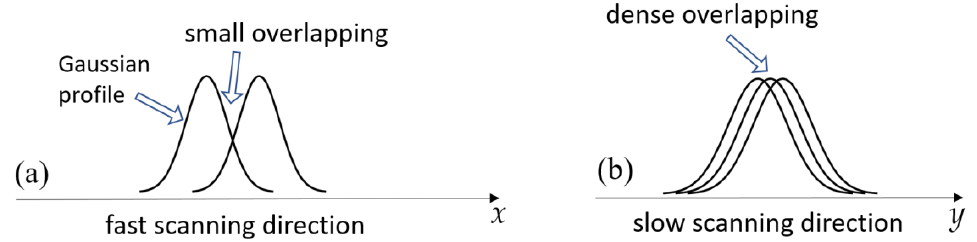
Figure 2. Illustration of the scanning of biological tissue along fast ( a ) and slow ( b ) scanning directions.